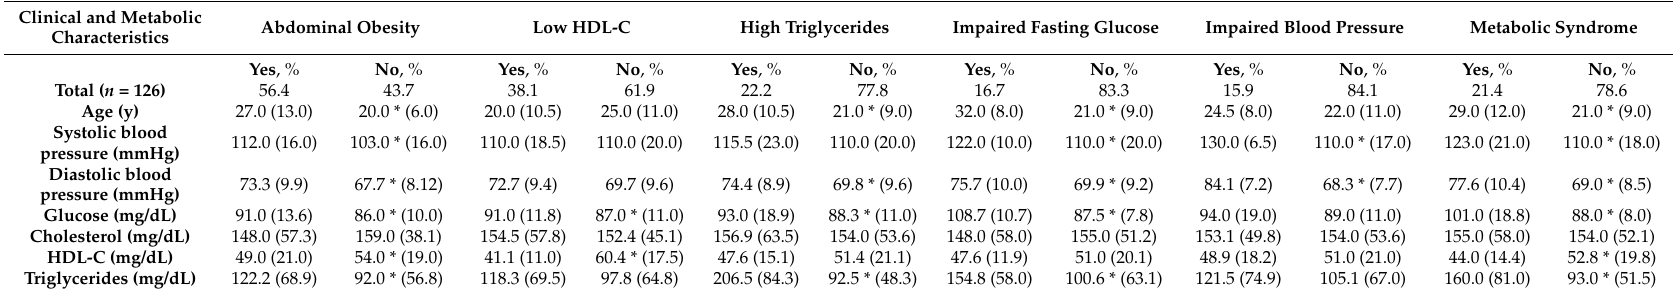
Table 1. Prevalence of metabolic syndrome risk factors and distribution of clinical characteristics by metabolic syndrome status. Clinical and Metabolic